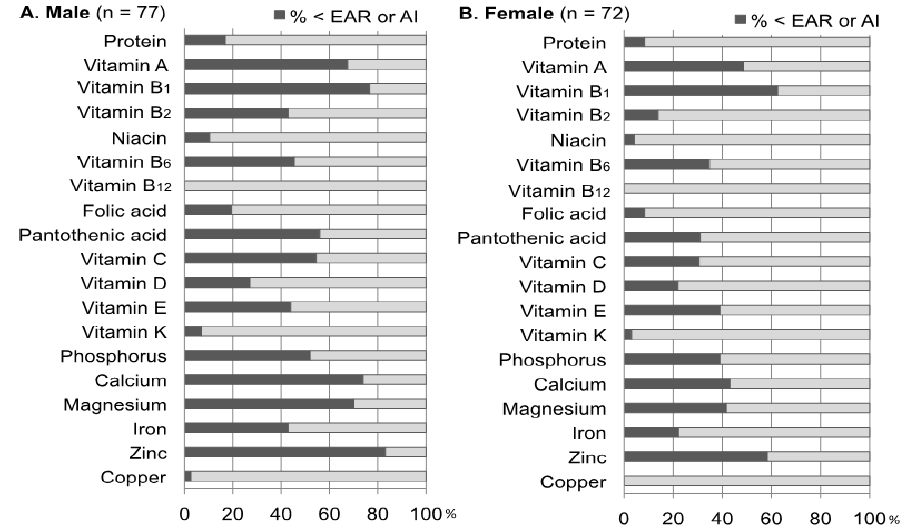
Figure 1. Assessment of the nutrient intake using the estimated average requirement (EAR) and adequate intake (AI) within Dietary Reference Intakes (DRIs) for Japanese. The percentages of patients who showed intakes less than the EAR or AI to the whole were presented for individual nutrients. For these calculations, the EAR or AI values for the age classes (40–49, 50–69, and over 70 years) of each patient were used.